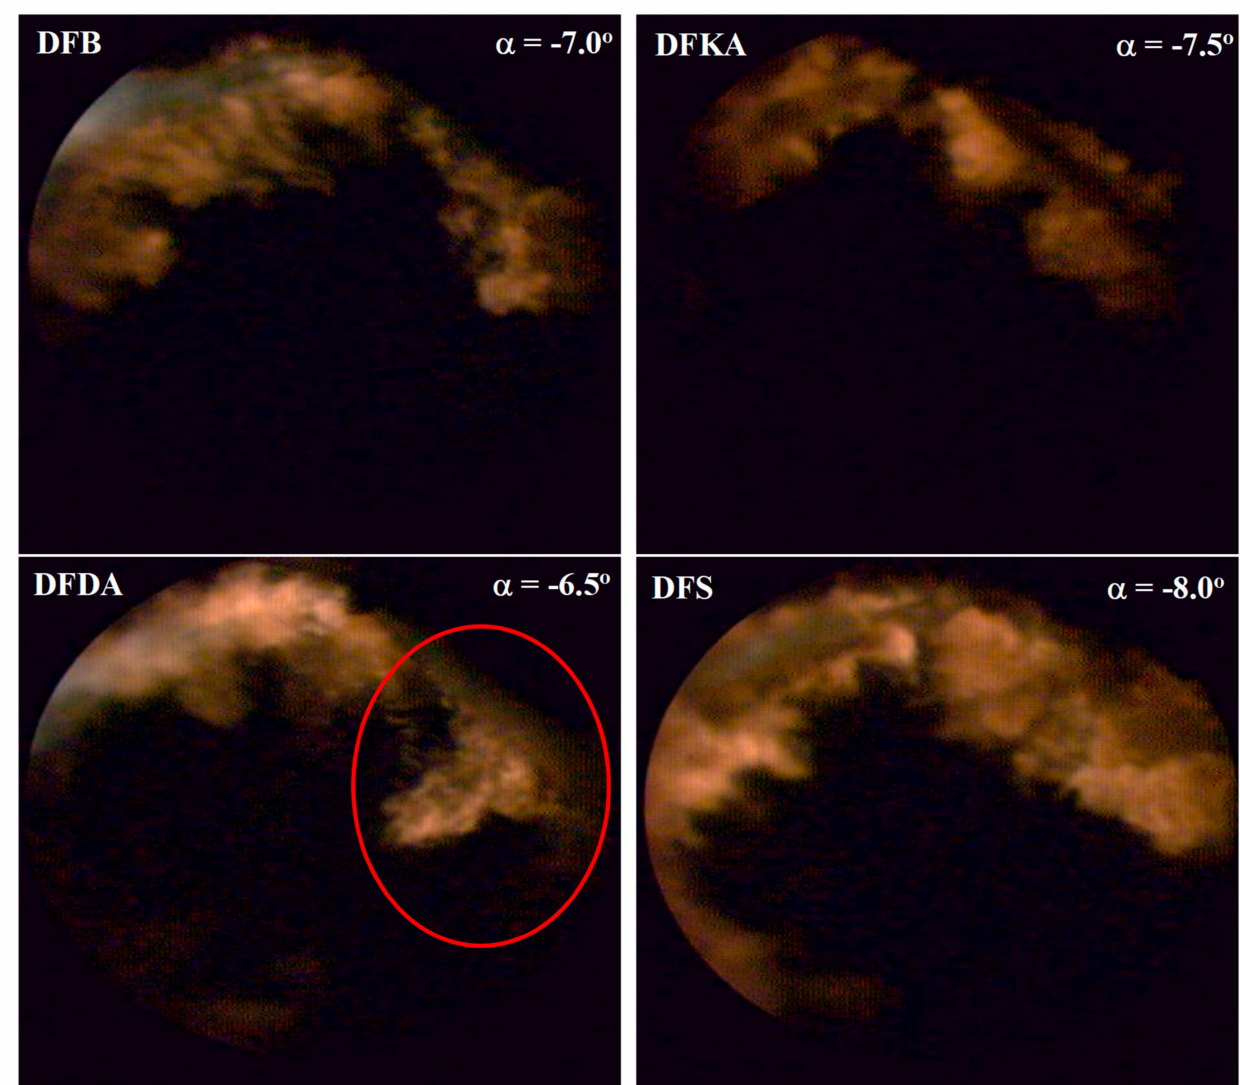
Figure 28. Image inside engine cylinder for crankshaft angle of rotation corresponding to maximum rate of kinetic combustion α dQk_max